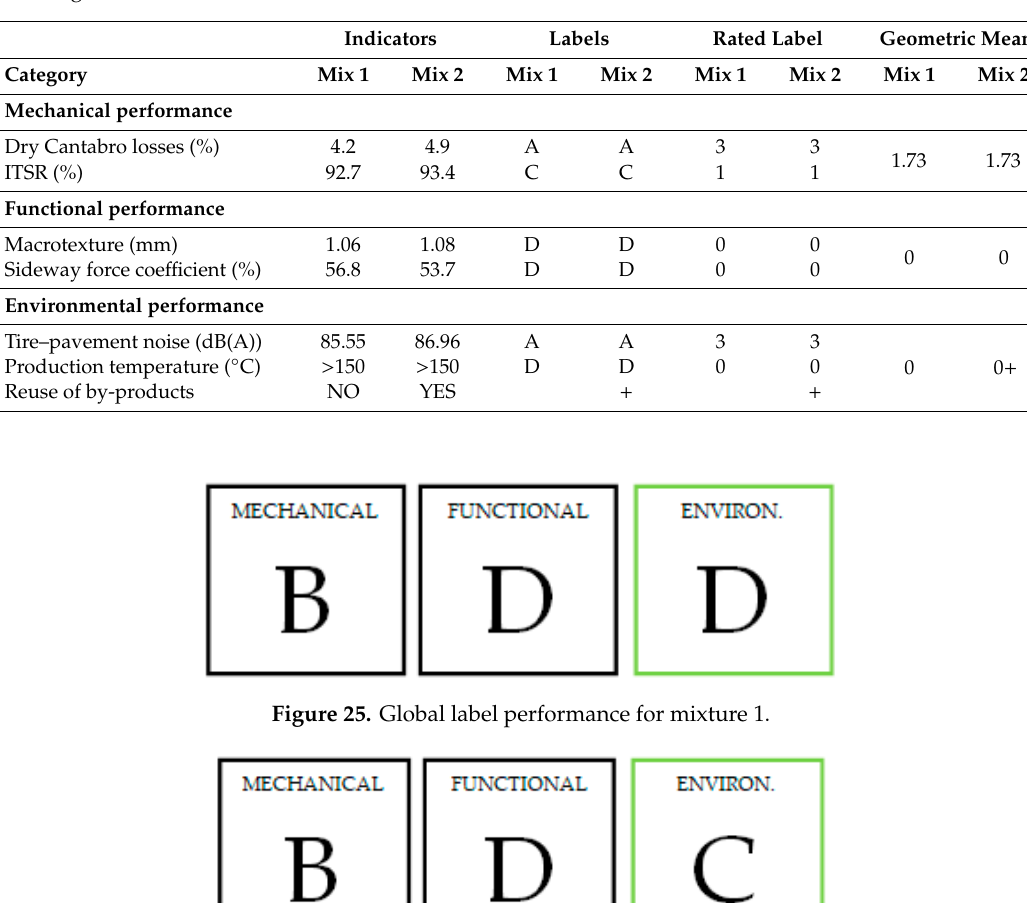
Table 4. Mechanical, functional, and environmental properties of the mixtures. ITSR—indirect tensile strength ratio.